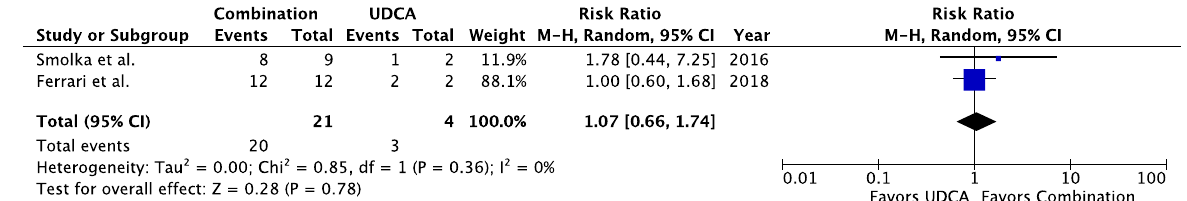
Figure 9. Biochemical improvement in AIC patients treated with immunosuppression vs. UDCA. Steroid = corticosteroids, AZA = azathioprine, and UDCA = ursodeoxycholic acid.